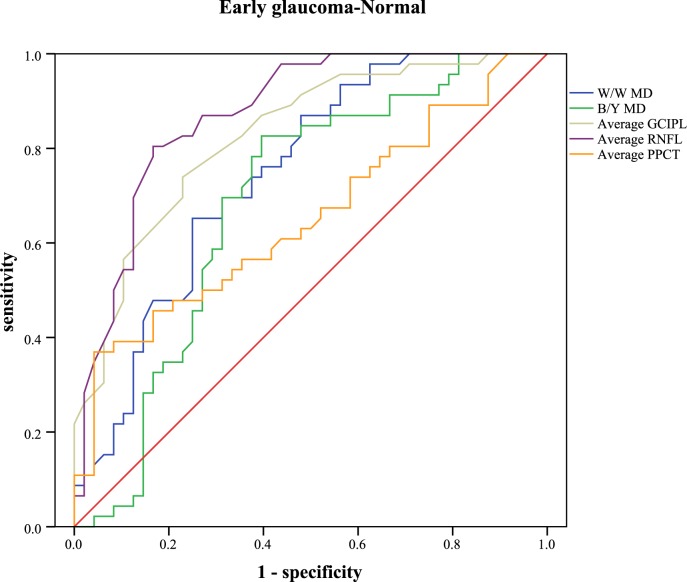
ROC curves for visual field indices and OCT parameters to discriminate early glaucomatous eyes from normal eyes.